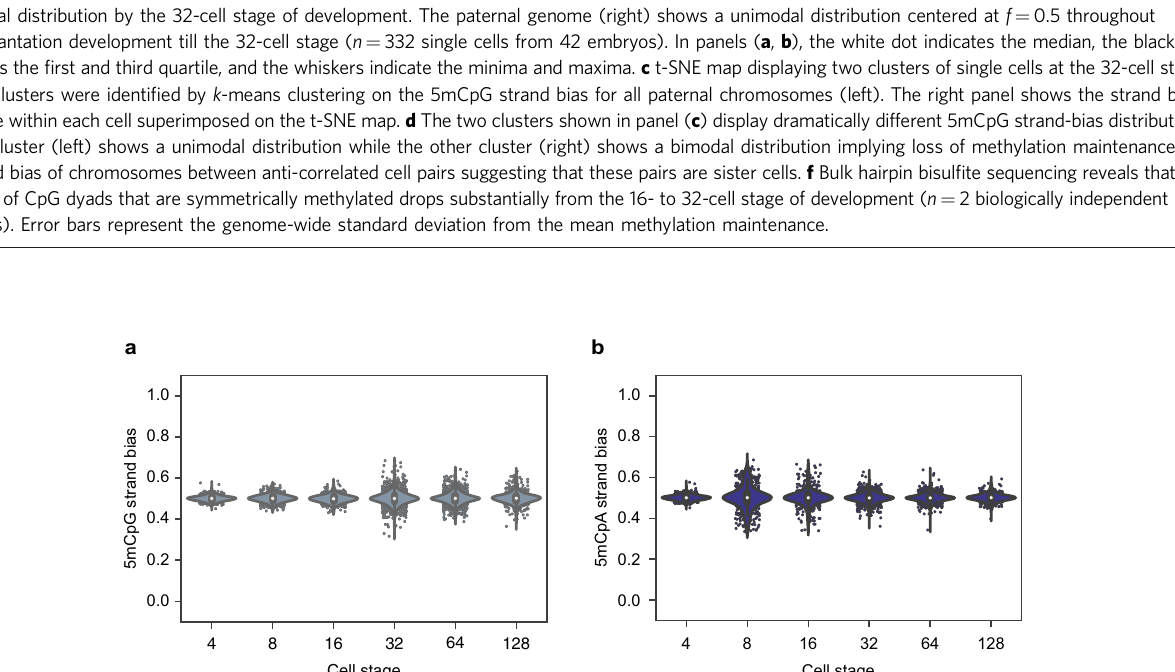
Fig. 5 DNA demethylation dynamics in preimplantation human embryos. a Violin plots showing 5mCpG strand bias from the 4- to 128-cell stage of human embryogenesis. In the absence of allele-speci fi c information, the strand bias represents an average over both alleles. Similar to mouse embryos, human embryos initially show no 5mCpG strand bias followed by an increase at the 16-cell stage of embryogenesis. b Violin plots showing 5mCpA strand bias from the 4- to 128-cell stage of human embryogenesis. 5mCpA strand bias dynamics in human embryos is similar to that observed in mouse embryos in Fig. 4b. In these panels, the white dot indicates the median, the black bar indicates the fi rst and third quartile, and the whiskers indicate the minima and